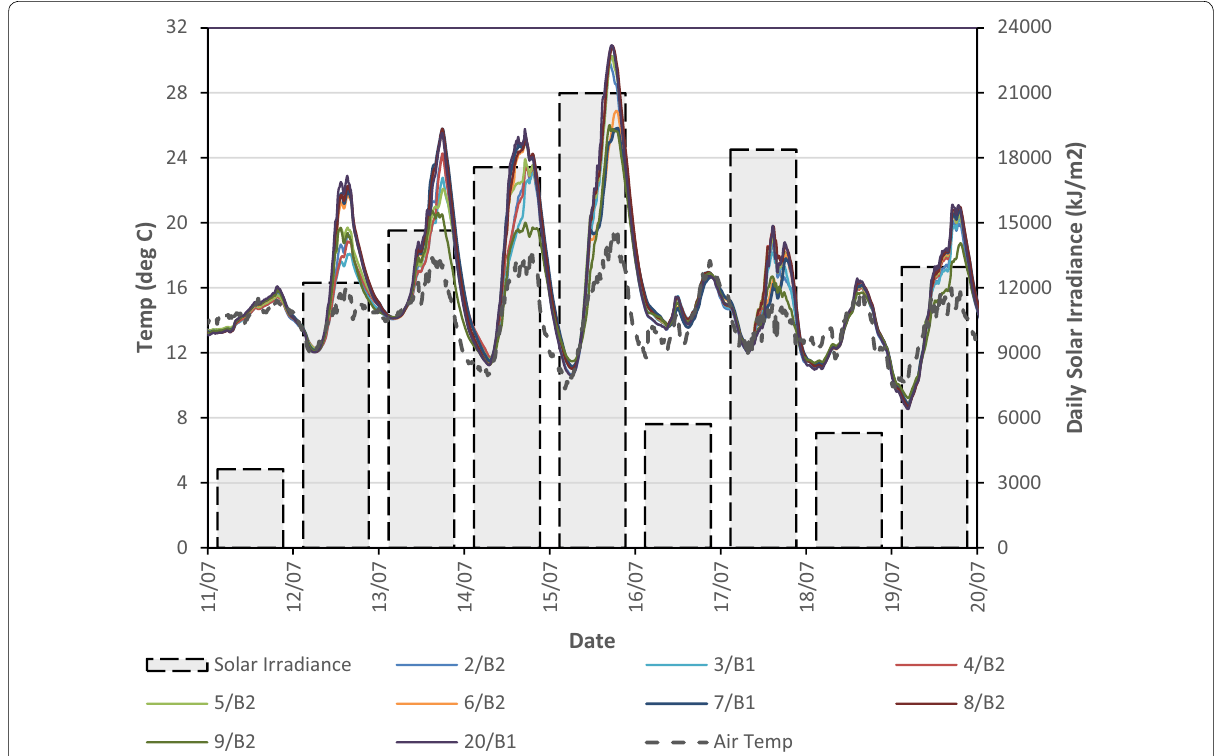
Fig. 16 Comparison of concrete temperature and solar irradiance in the precast